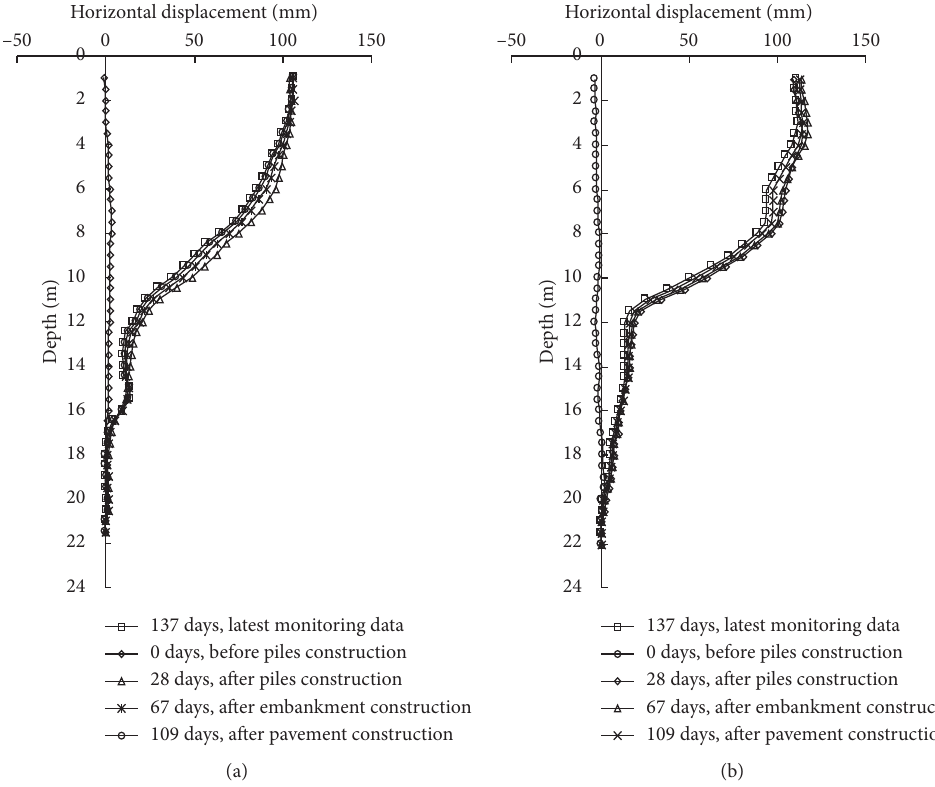
Figure 16: Variation of cumulative horizontal displacement in different construction stages. (a) Left embankment. (b) Right embankment.